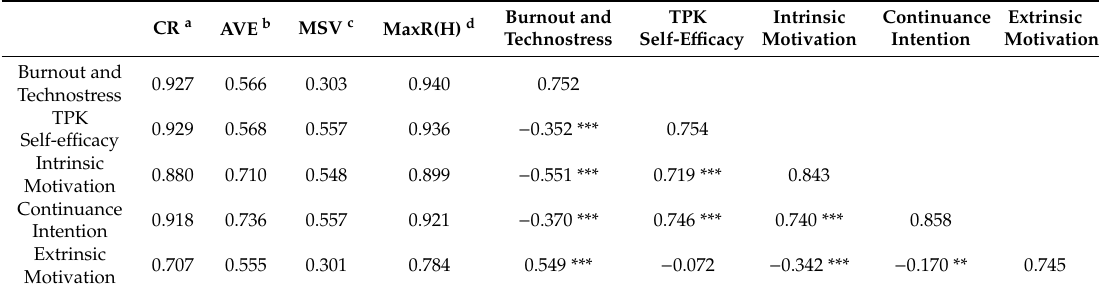
Table 2. Convergent and discriminant validity coefficients as results of the analysis of structural validity of measurement scale ( n 2 = 518) .